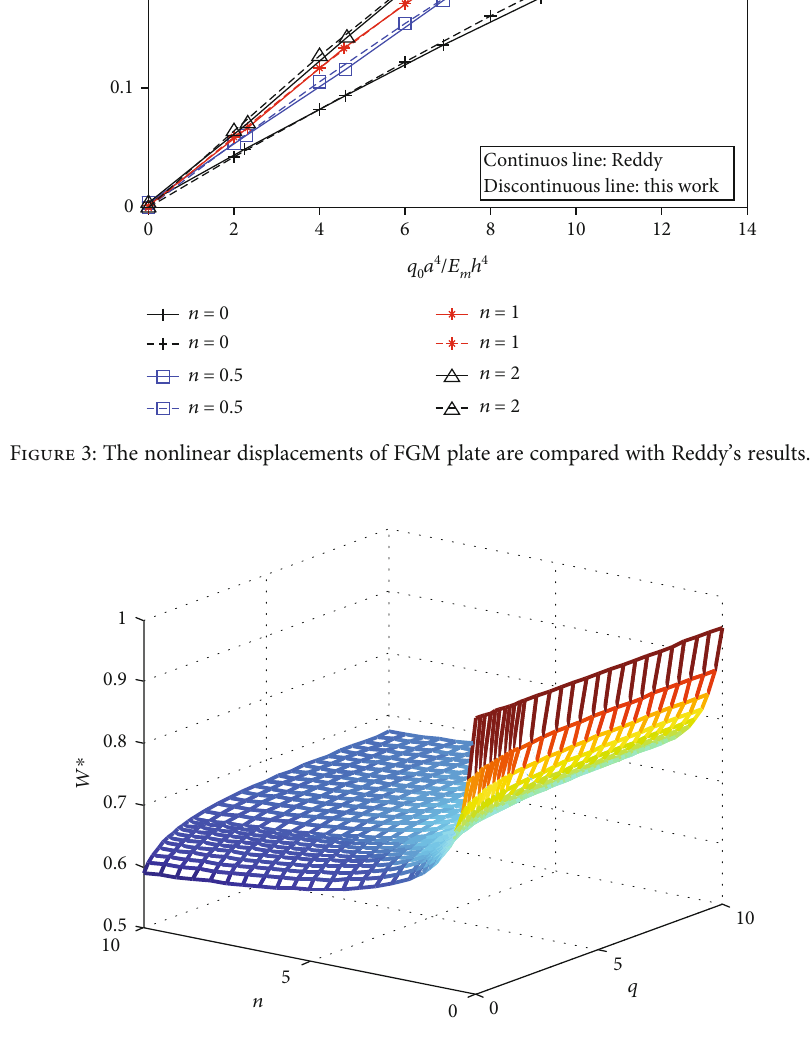
Figure 4: E ff ect of n and q on the maximum de fl ection of the 2D-FGM